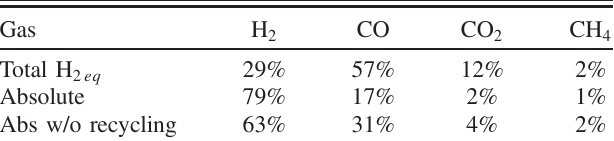
TABLE XI. Gas composition ratios of the main four species, for an arbitrary dose of 120